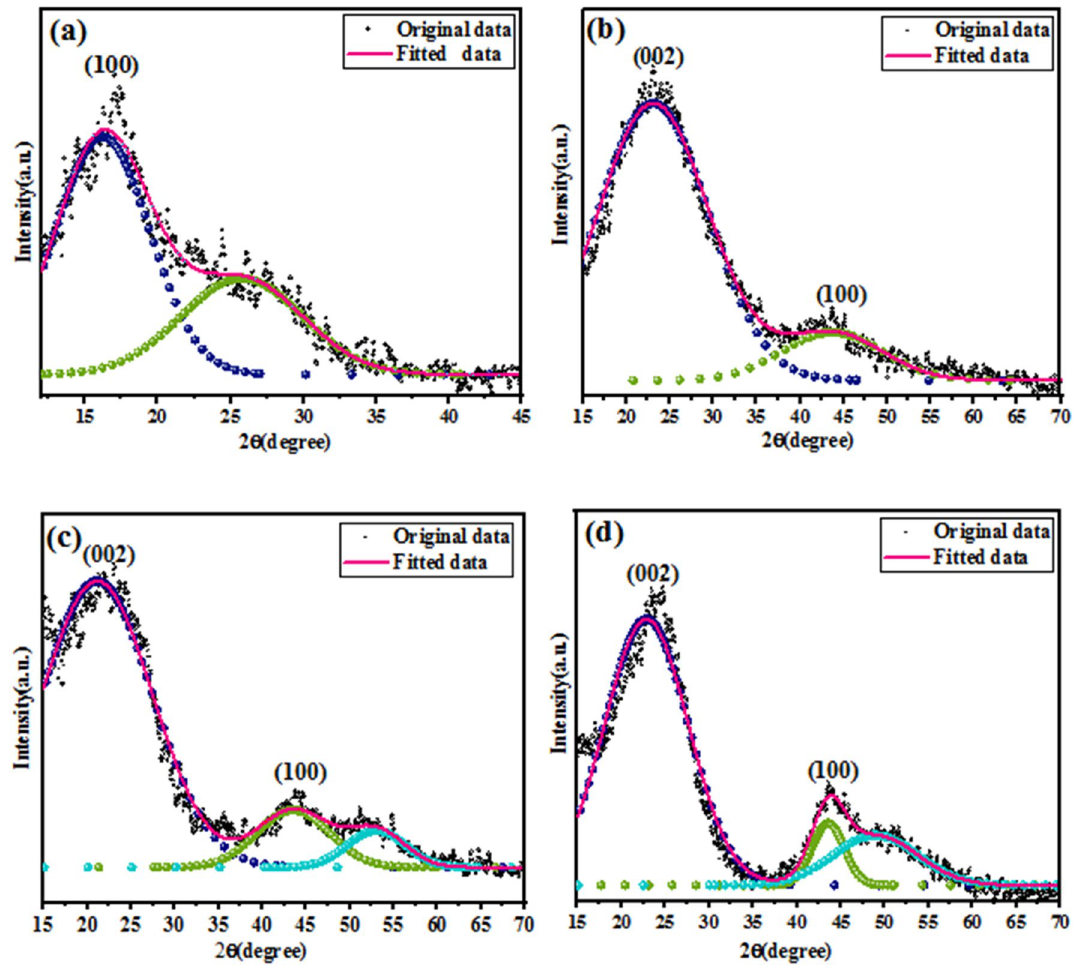
Figure 6. Deconvolution of XRD patterns of ( a ) as-spun PAN, ( b ) C1, ( c ) C2, and ( d ) C3